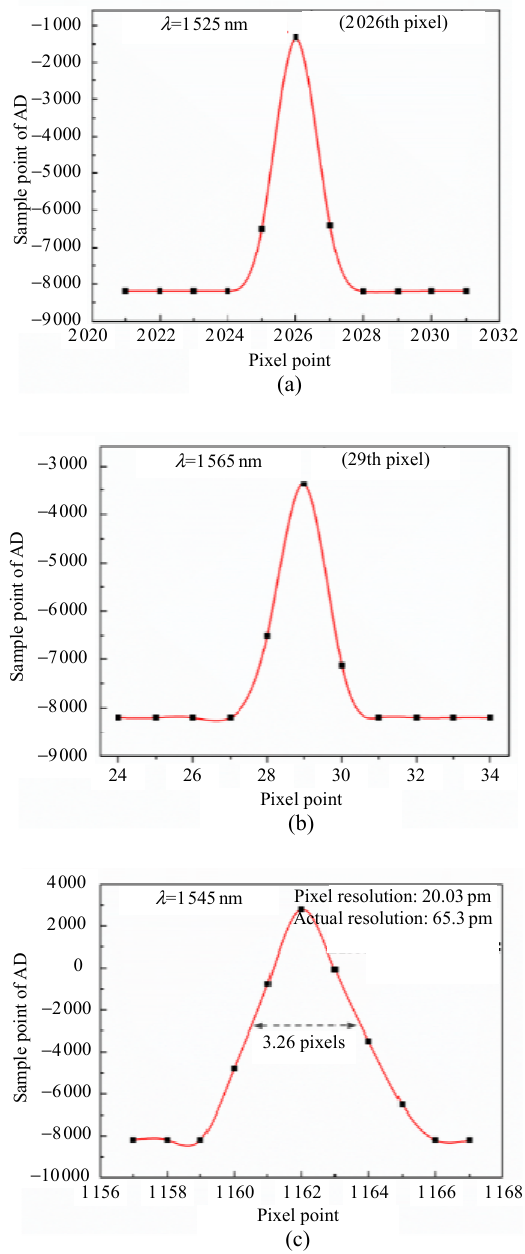
Fig. 6 Calibration results of the spectrometer: (a) the pixel position corresponding to 1 525 nm, (b) the pixel position corresponding to 1 565 nm, and (c) the pixel position corresponding to 1 545